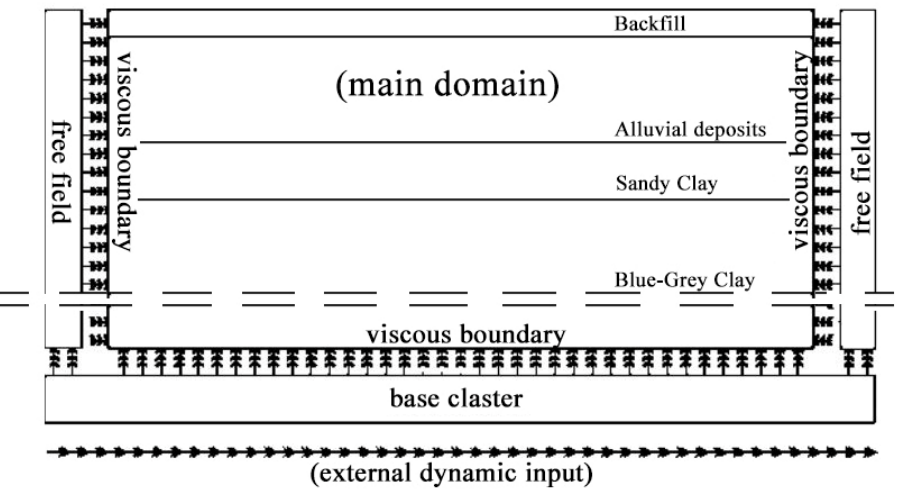
Figure 16. Free field boundary condition with compliant base (After References [38,39], modified).